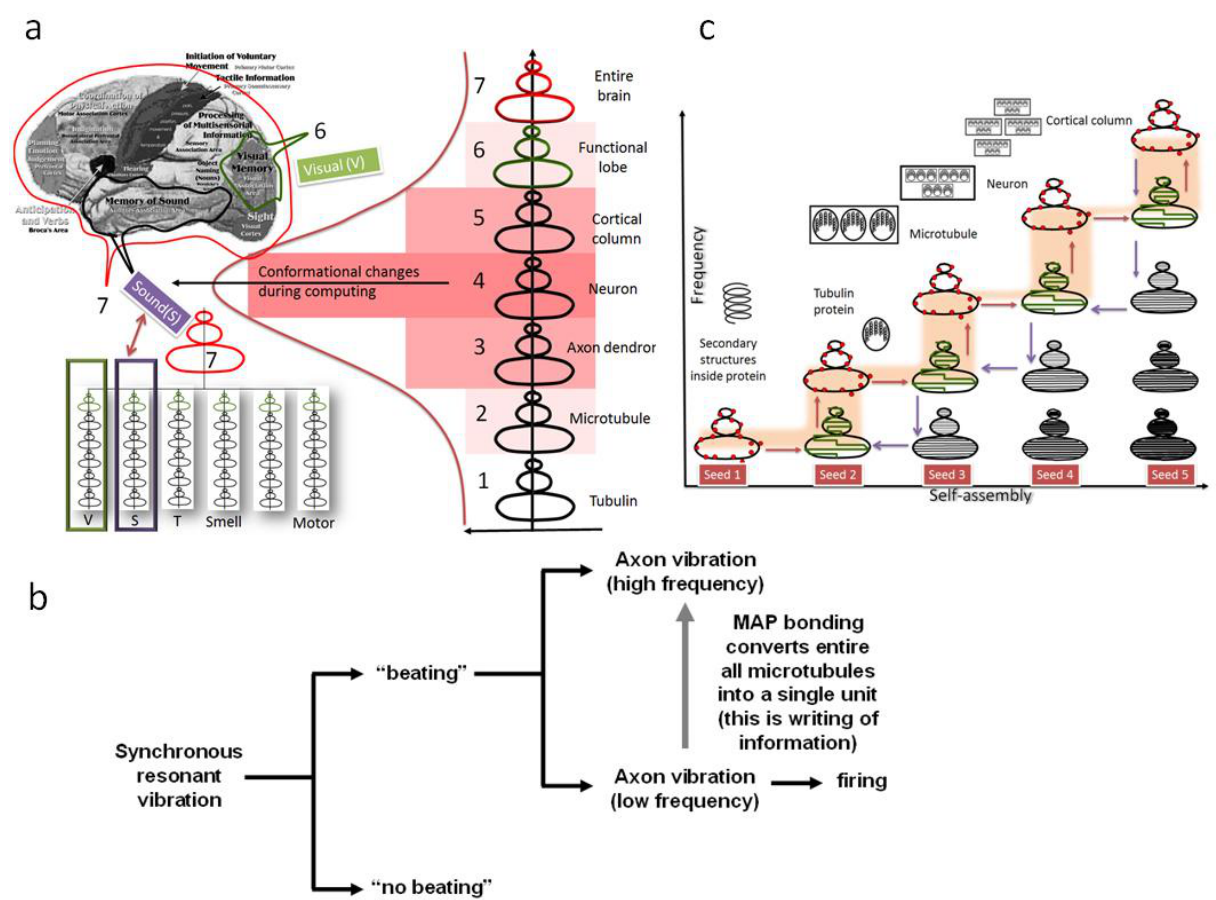
( b ) The both routes of energy transmission paths in the human brain; ( c ) The mechanism of ―beating‖, how brain decides writing and when actually brain decides to